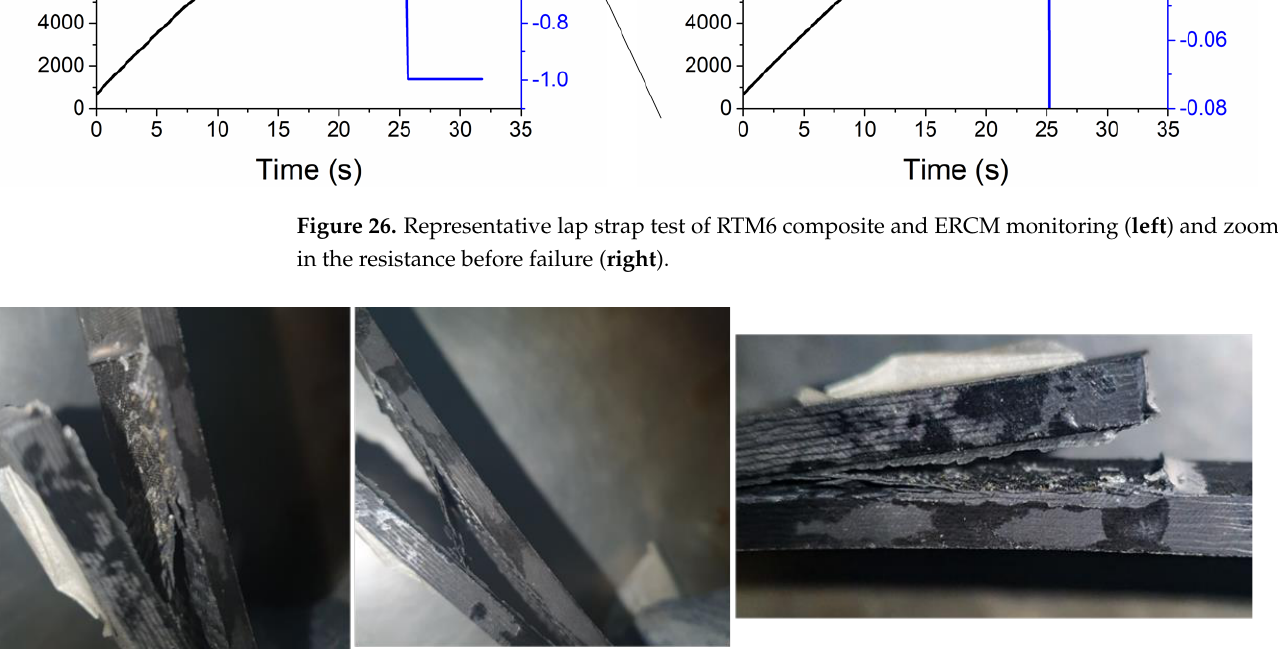
Figure 28. Representative lap strap test of the 3R composite with ERCM monitoring.